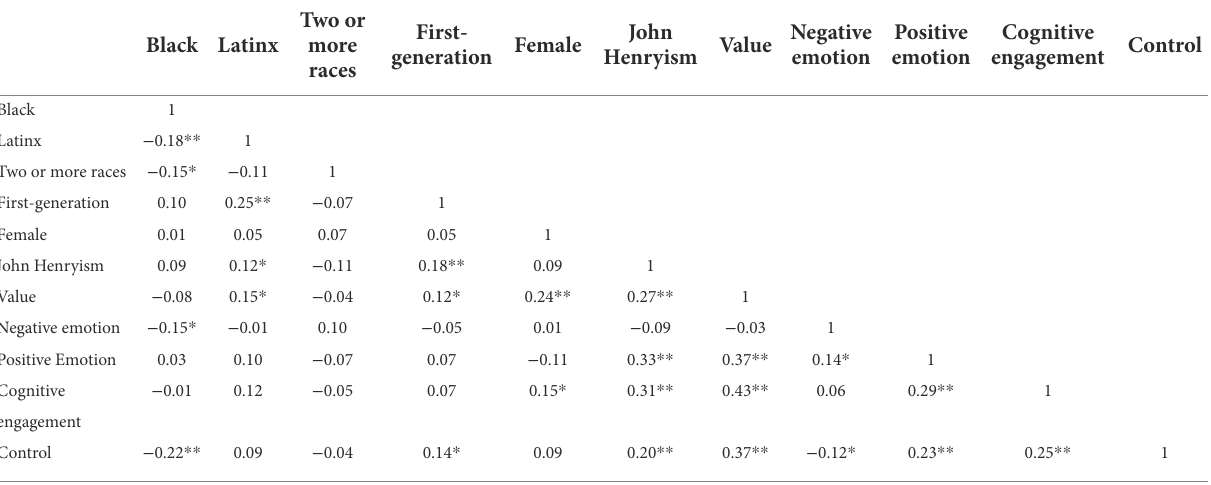
TABLE 2 Bivariate correlations.